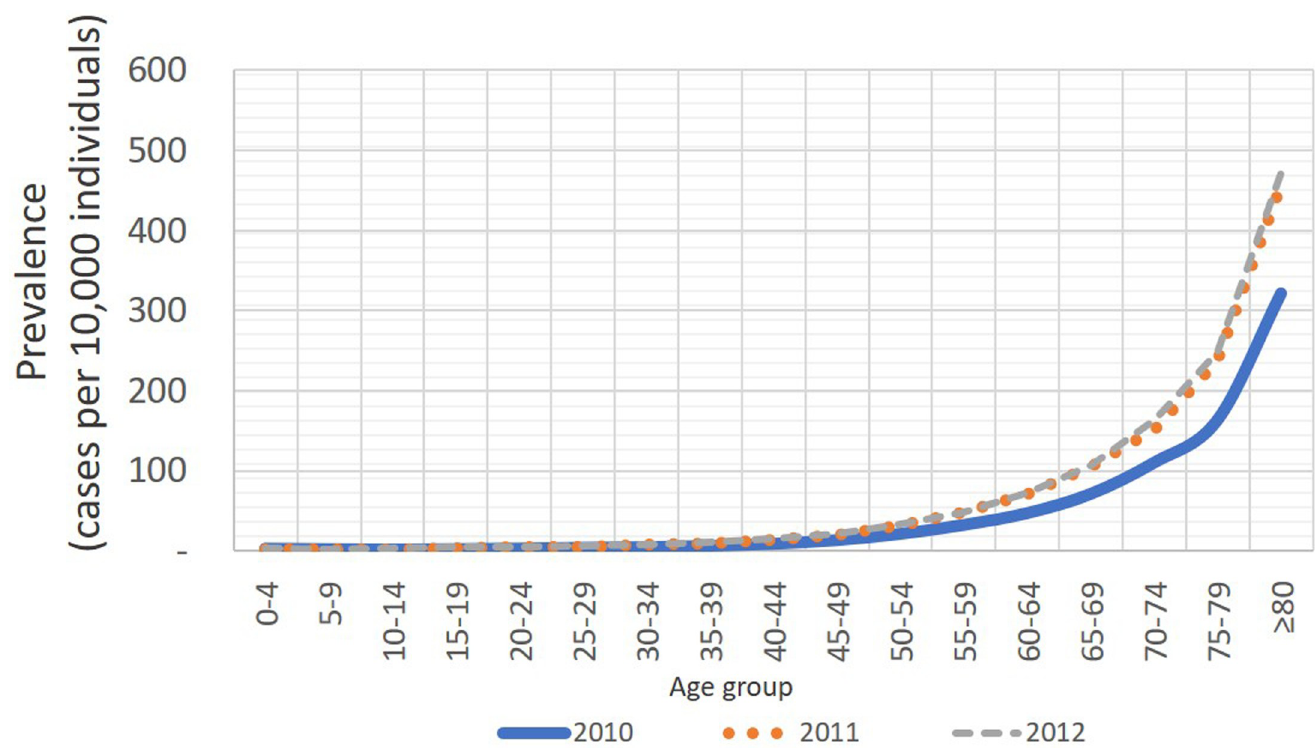
Fig 3. Distribution of STR prevalence by age and year.